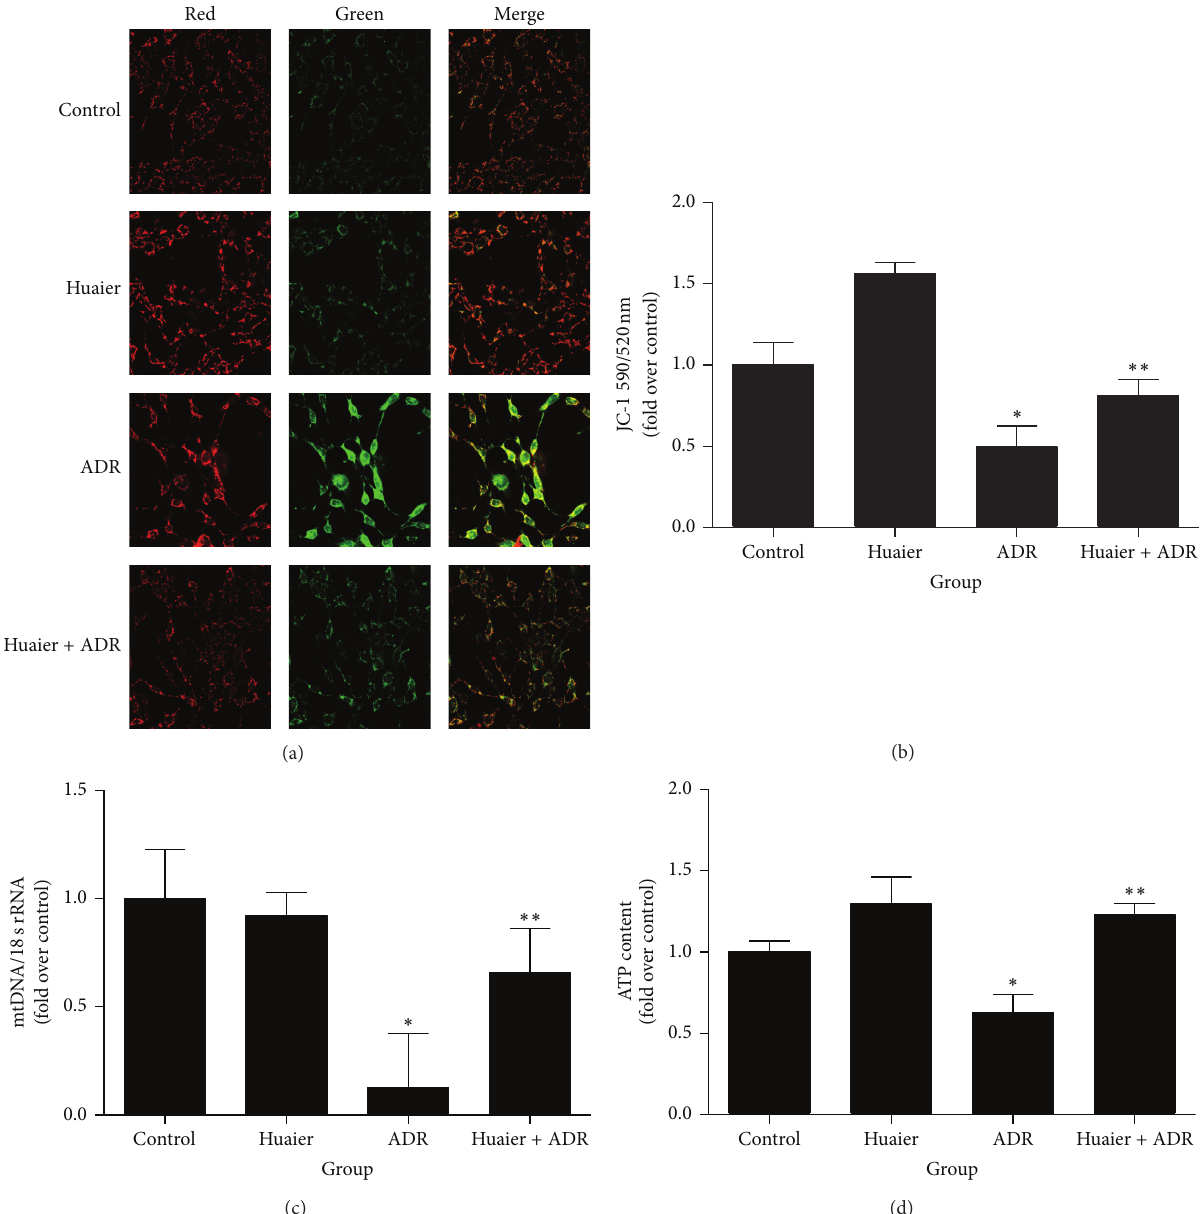
Figure 3: Huaier blocked ADR-induced mitochondrial dysfunction in vitro . (a) Representative images of podocytes stained with JC-1. (b) MMP measurements by flow cytometry. (c) Real-time RT-PCR analysis of mtDNA copy number. (d) ATP content. Podocytes were pretreated with Huaier (0.2mg/mL) for 1 h followed by incubation with ADR (200 nM) for further 24 h. Data are expressed as the means ± SD ( 𝑛 = 6 ). ∗ 𝑃 < 0.05 versus control. ∗∗ 𝑃 < 0.05 versus ADR